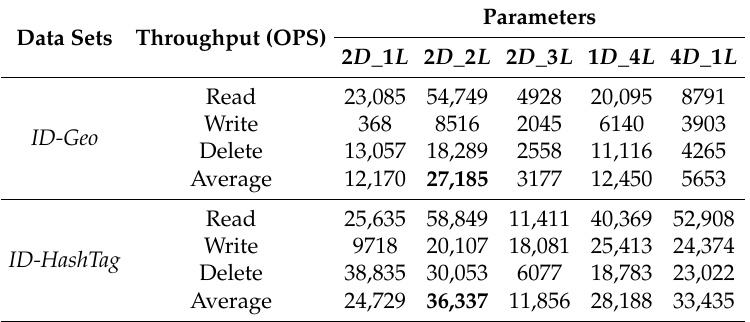
Table 7. The best settings of WR-Store for real data